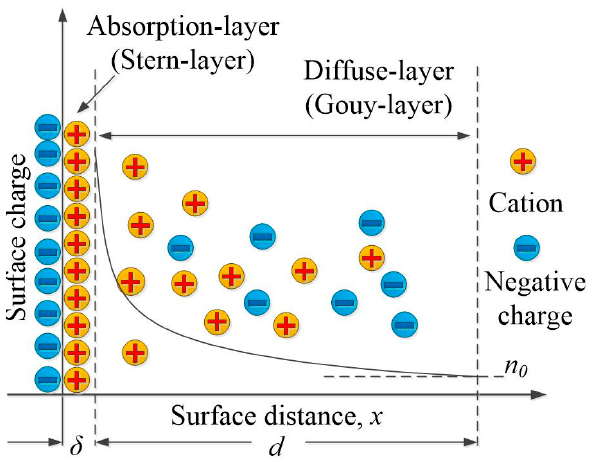
Figure 1. Illustration of the electrical double-layer model; δ is the thickness of adsorption-layer; d is the thickness of the diffuse-layer; n 0 is the soil solution concentration.